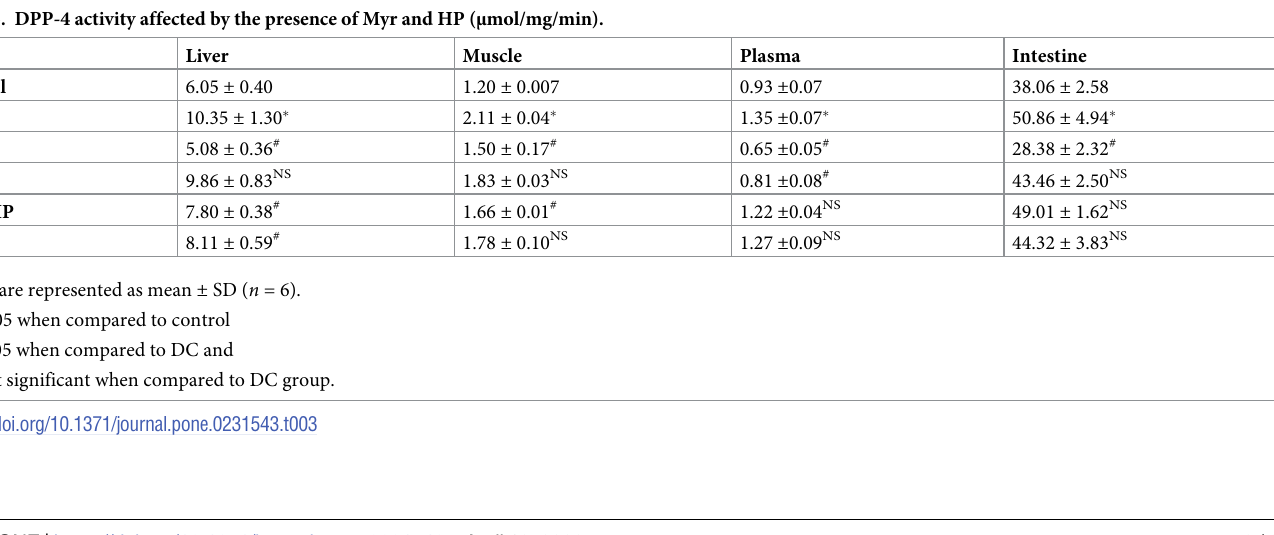
week compared to NFD (Table 3). After the administration of STZ to the HFD group at the 10 th week, the blood glucose levels showed above 200 mg/dL, i.e., 444 ± 29.5 mg/dL. After the confirmation of onset of diabetes by elevated blood glucose level ( > 200 mg/dL), rats were divided into groups and administered with Myr, HP, Myr+HP, and MTF, individually, for four weeks. The blood glucose levels were monitored and shown in Table 2 . The DC rats, without treatment, exhibited significantly (P < 0.05) high blood glucose levels compared to the control group during the period. Myr treated groups showed significant (P < 0.05) decrease in the blood glucose level by 12%, 9%, 11%, and 28% during the 11 th ,12 th , 13 th and 14 th weeks, respectively, compared to DC. HP had no significant effect on elevated blood glucose level at 11 th , 12 th , and 13 th week, however, the group exhibited reduced (13%) elevated blood glucose level in the 14 th week of treatment compared to DC. There was a significant (P < 0.05) reduc- tion in the elevated blood glucose level in the group treated with Myr+HP in 11 th , 12 th , 13 th and 14 th week by 20%, 27%, 27%, and 11%, respectively, compared to DC. MTF treatment was significantly (P < 0.05) efficient in the reduction of elevated blood glucose level by 20%, 23%,